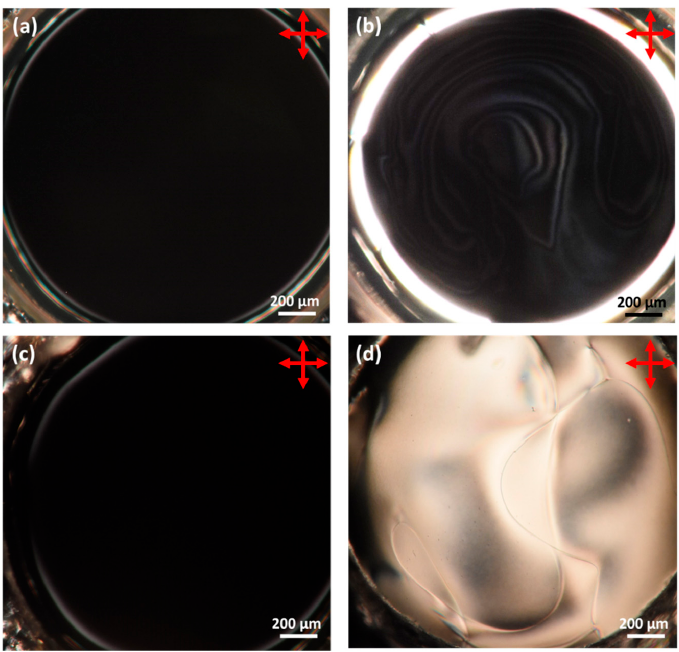
Figure 4. Transmission POM images of freely suspended LC films at an air interface. ( a ) E7, ( b ) MLC2081, ( c ) MLC6609 and ( d ) MLC7023. Images for E7 and MLC7023 reproduced with permission from the American Chemical Society from Paterson et al. [20].